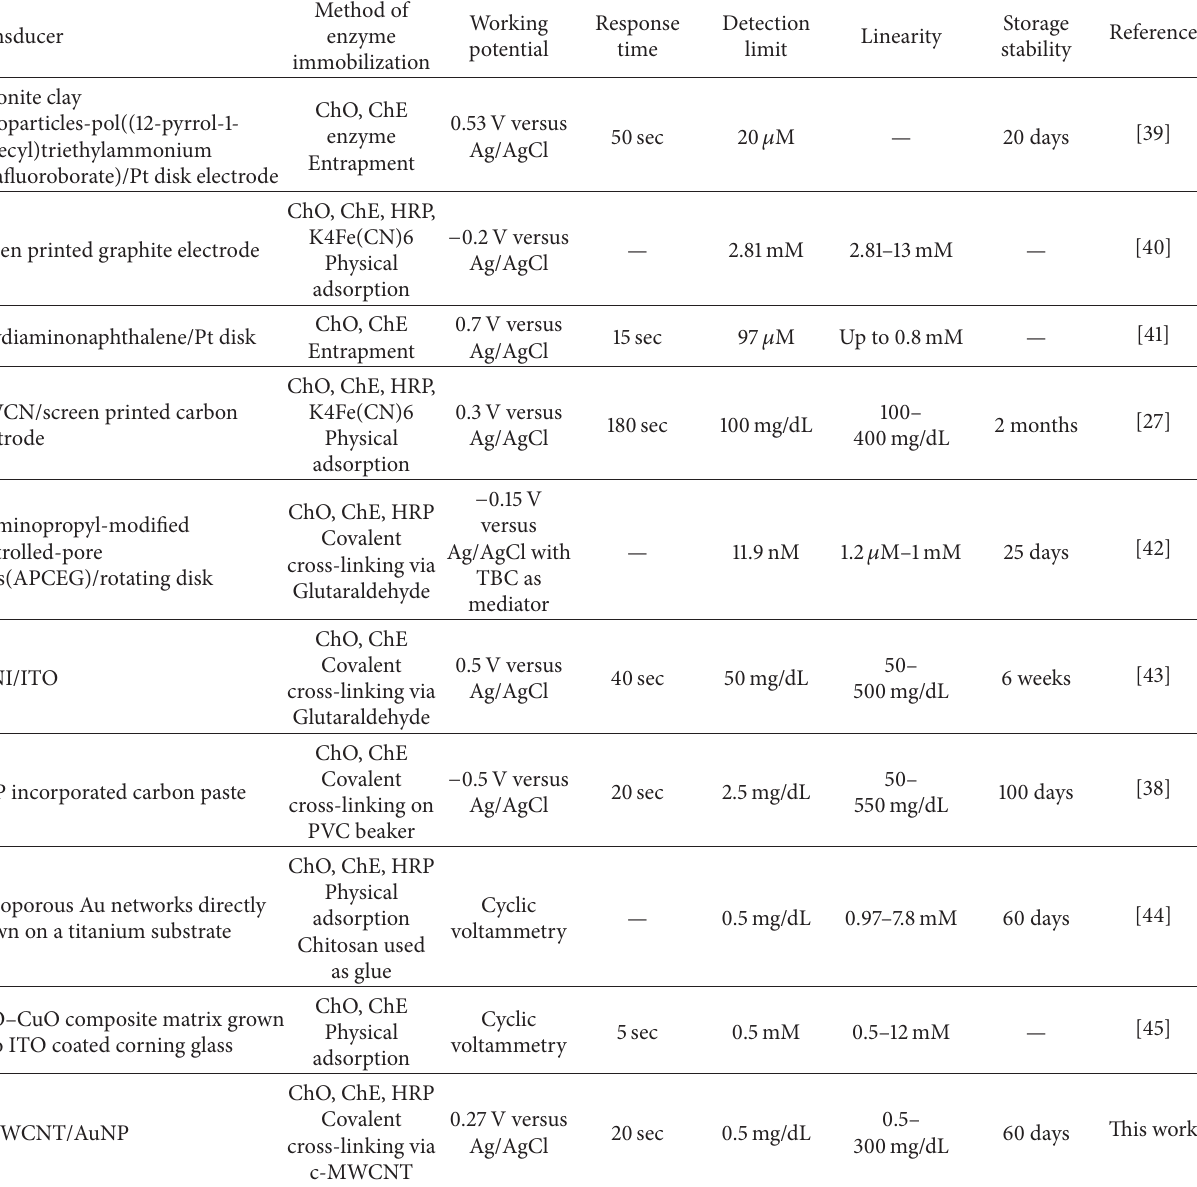
Table 6: Comparison of the present method with previously reported biosensor for total cholesterol